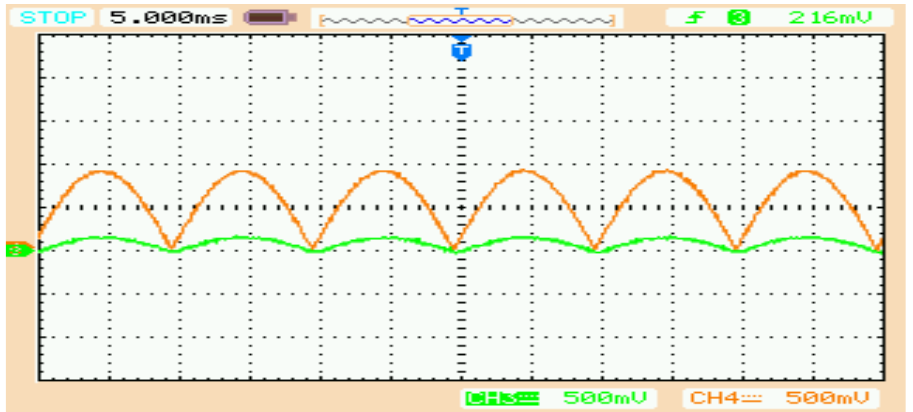
Figure 26. Rectified input supply voltage profile (in orange) along with inductor/line current (in green) for the same value of inductors in parallel ‐ connected converters.